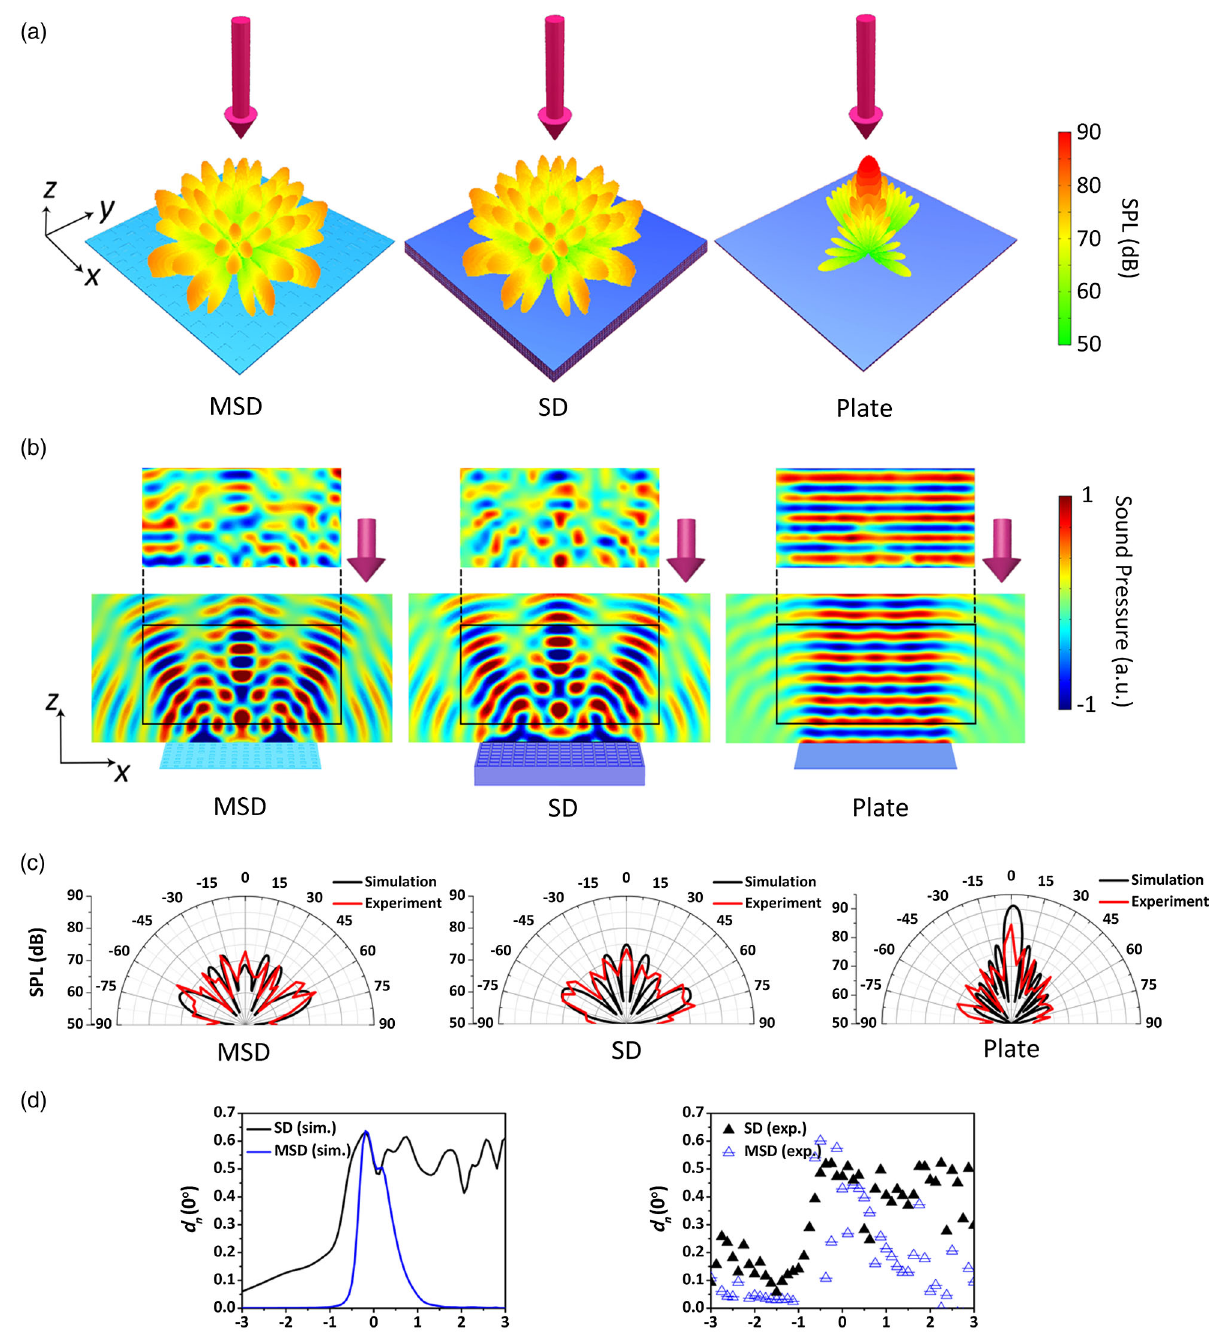
FIG. 3. Simulation and experimental results of the MSD for normal incidence. (a) The simulated three-dimensional far-field scattering patterns of the MSD, SD, and flat plane with normal incidence. (b) The measured (upper) and simulated (lower) scattered acoustic field distributions of the MSD, SD, and flat plate in the x - z plane. (c) The simulated and measured scattering field directivity of the MSD, SD, and plate. (d) Simulated and measured normalized diffusion coefficient d n ð 0 ° Þ versus frequency for the MSD and SD,